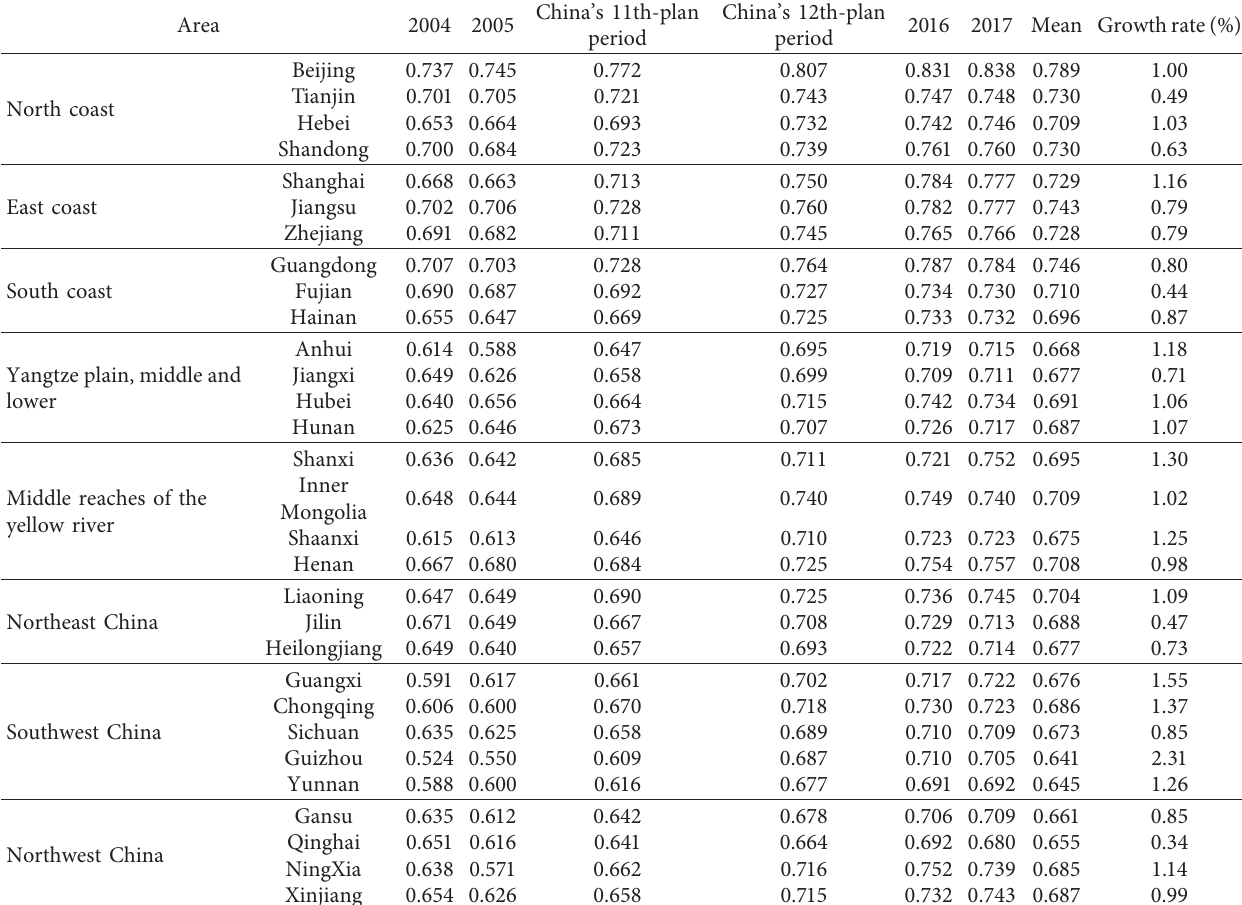
Table 7: The CCD of China from 2004 to